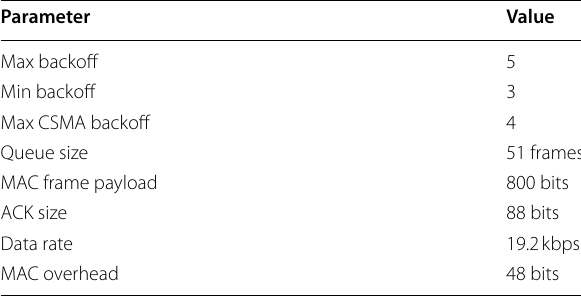
Table 3 Simulation parameters